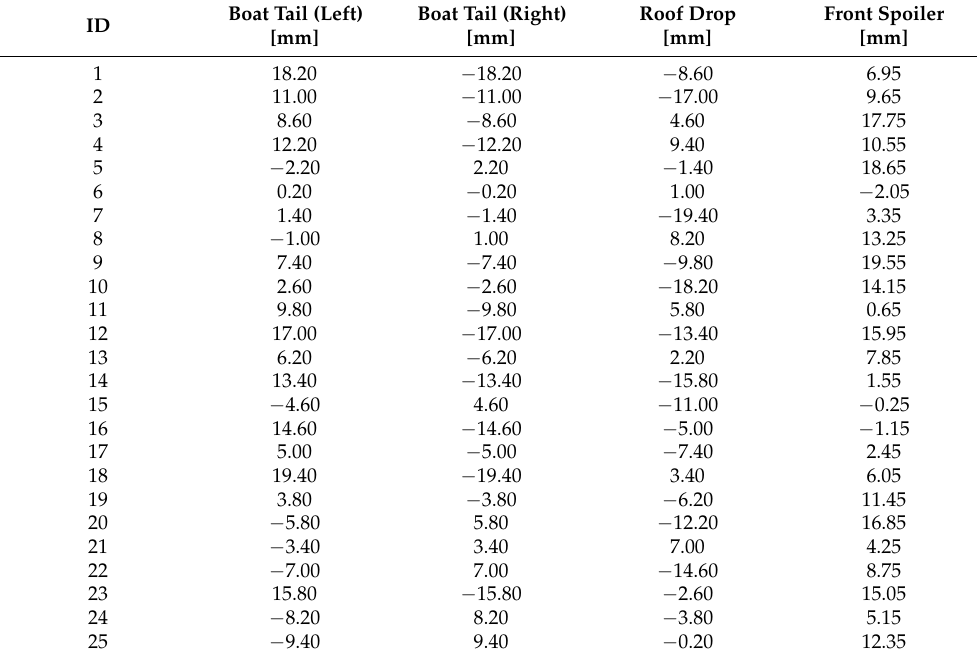
Table A1. DoE table of the ASMO test